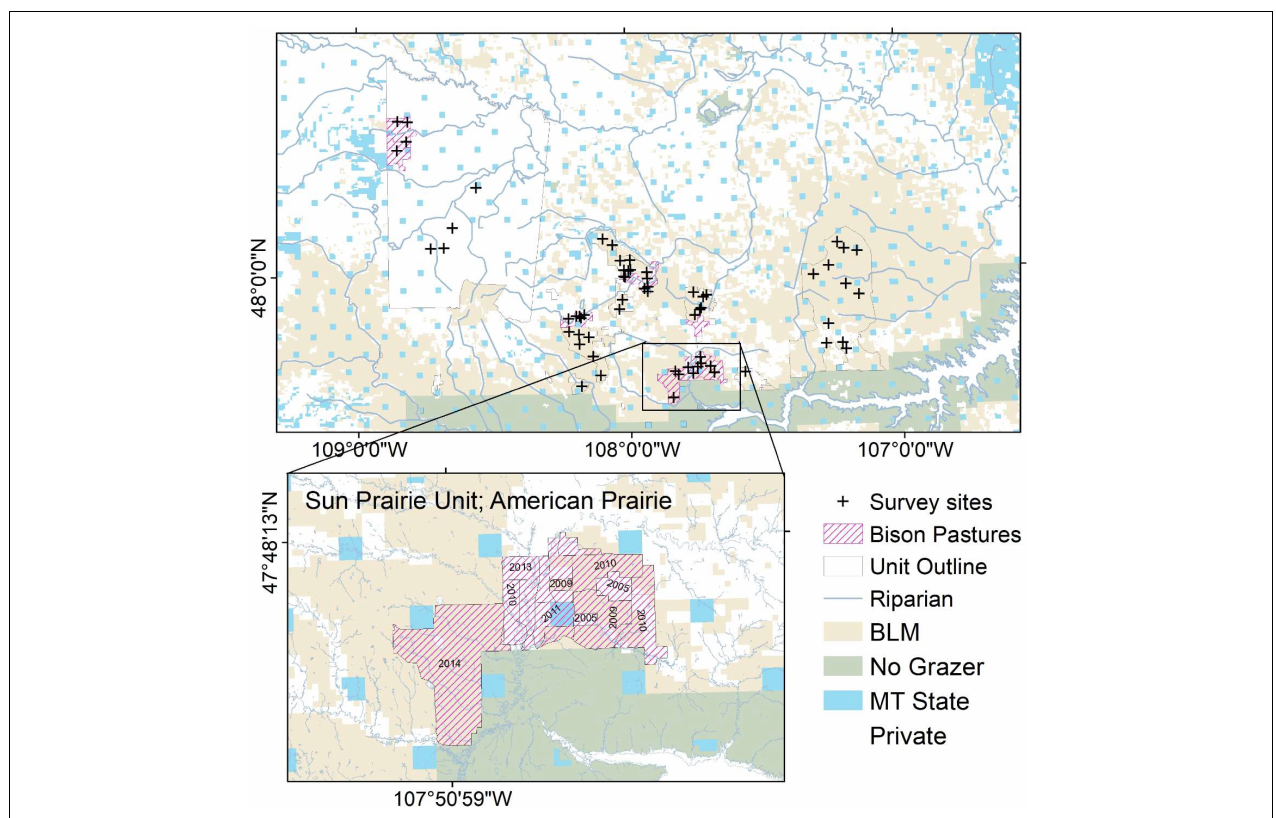
FIGURE 1 | Survey sites. Unit outlines include Fort Belknap Indian Reservation and American Prairie